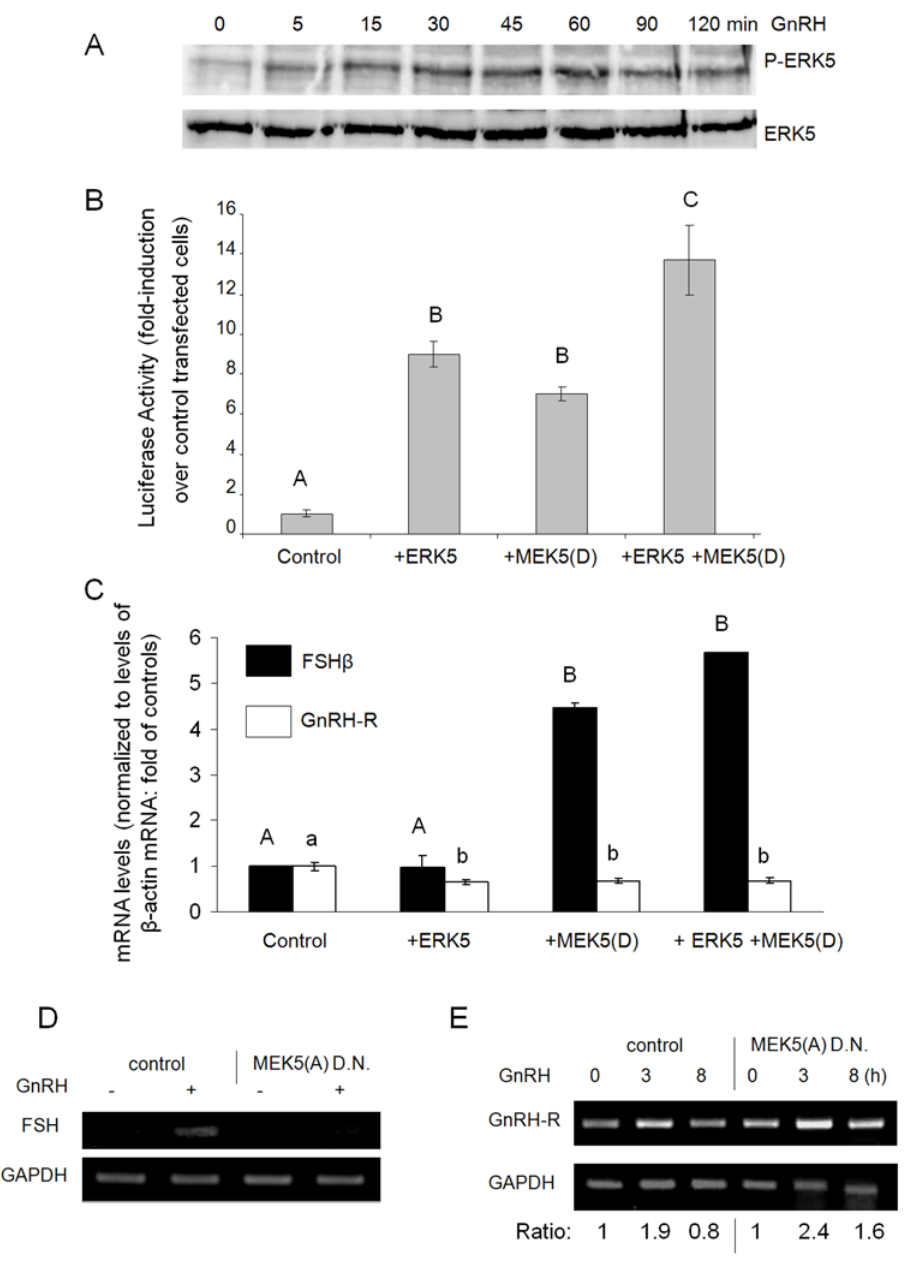
Figure 3. GnRH increases FSH b gene expression through activation of ERK5. (A) L b T2 cells were cultured and exposed to GnRH for 0–2 h, before lysis and western analysis using pERK5 (upper panel) or total ERK5 (lower panel) antisera. (B) The mouse FSH b -luc construct (200 ng), and ERK5 or constitutively-active MEK5(D) expression vectors, or both (50 ng each) were transfected into a T3-1 cells in 96-well plates. Luciferase levels were normalized to those of Renilla, and results show the fold induction over untreated FSH b -luc control-transfected cells. Mean 6 SEM, n=6. ANOVA followed by Bonferroni t-test compared means; those not significantly different (p . 0.05) are designated the same letter. (C) Cells were cultured in 6- well plates and transfected with 2 m g of ERK5 or MEK5(D) expression vectors or both; after 48 h, RNA was extracted for RT-PCR. Primers amplified 856 bp of FSH b , 200 bp of GnRH-R, or 200 bp of b -actin cDNA as control. The amplicons were run on an agarose gel, quantified by densitometry analysis, values normalized over those of b -actin and fold differences over control cells plotted. Mean 6 SEM, n=3. Statistical analysis (as in Figure 3B) was carried out separately for FSH b (upper case) or GnRH-R (lower case). (D) L b T2 cells in 60 mm plates were transfected with 4 m g of the dominant negative MEK5(A) construct 24 h prior to GnRH treatment for 8 h. RNA was extracted for RT-PCR; primers amplified the first 225 bp of FSH b or 230 bp of the GAPDH cDNA, as control. (E) Similarly, cells were transfected with the MEK5(A) construct before GnRH treatment for 3 or 8 h, after which the RNA was extracted, reverse-transcribed and primers amplified a fragment from the GnRH-R cDNA, or GAPDH, as control. The ratio of the GnRH-R amplicon, after normalization with GAPDH, relative to levels in untreated samples (with or without MEK5(A) is noted.